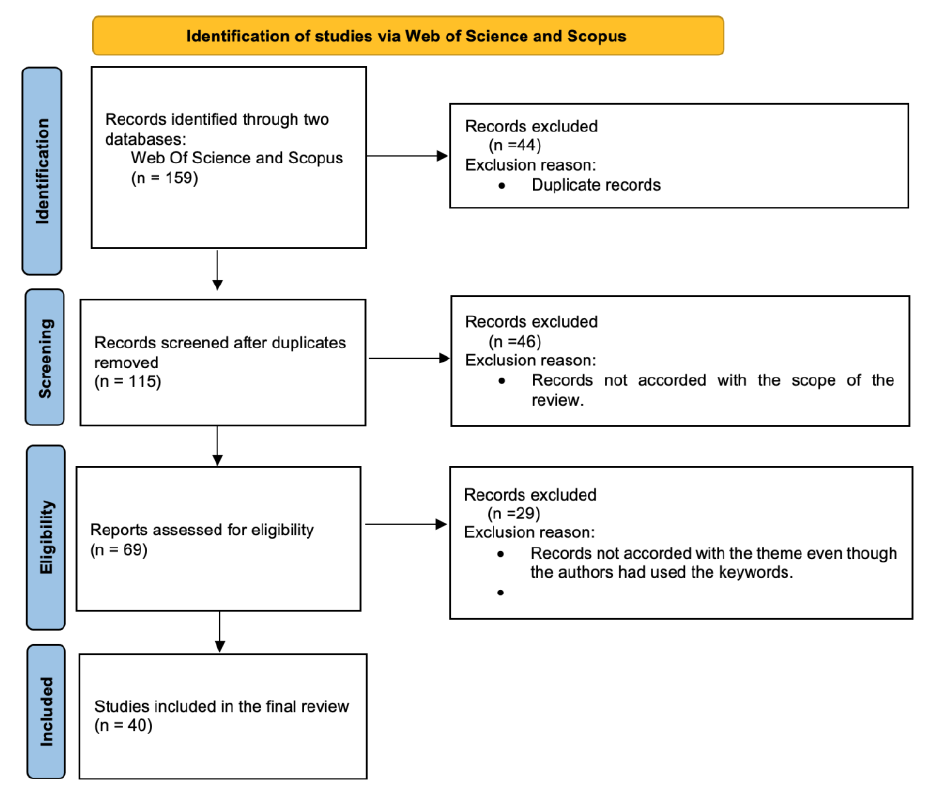
Fig. 1. PRISMA retrieval